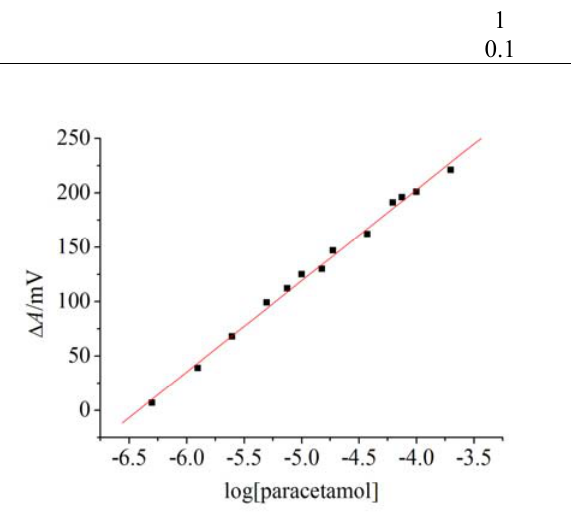
Figure 2 Calibration curve of the increase in amplitude vs. the logarithm of [paracetamol] in the range 5×10 -7 to 2×10 -4 M. Conditions: [NaBrO [H SO ] = 1.0 M; [[CuL](ClO 2 4